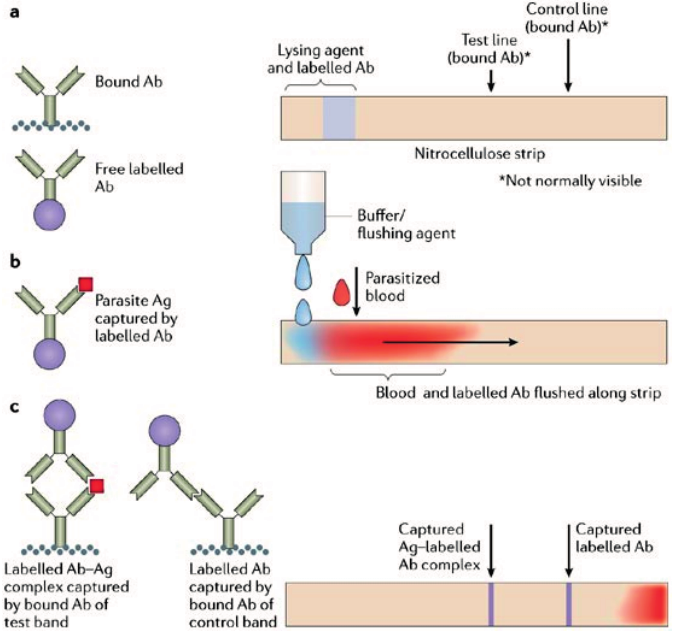
Figure 7. Schematic of the lateral flow strip to diagnose Malaria. (top) Layout of the strip, (middle) Flushing agent is added to help flush parasitized blood along the strip, and (bottom) visible lines indicate presence of antigens in the parasitized blood. Reproduced with permission